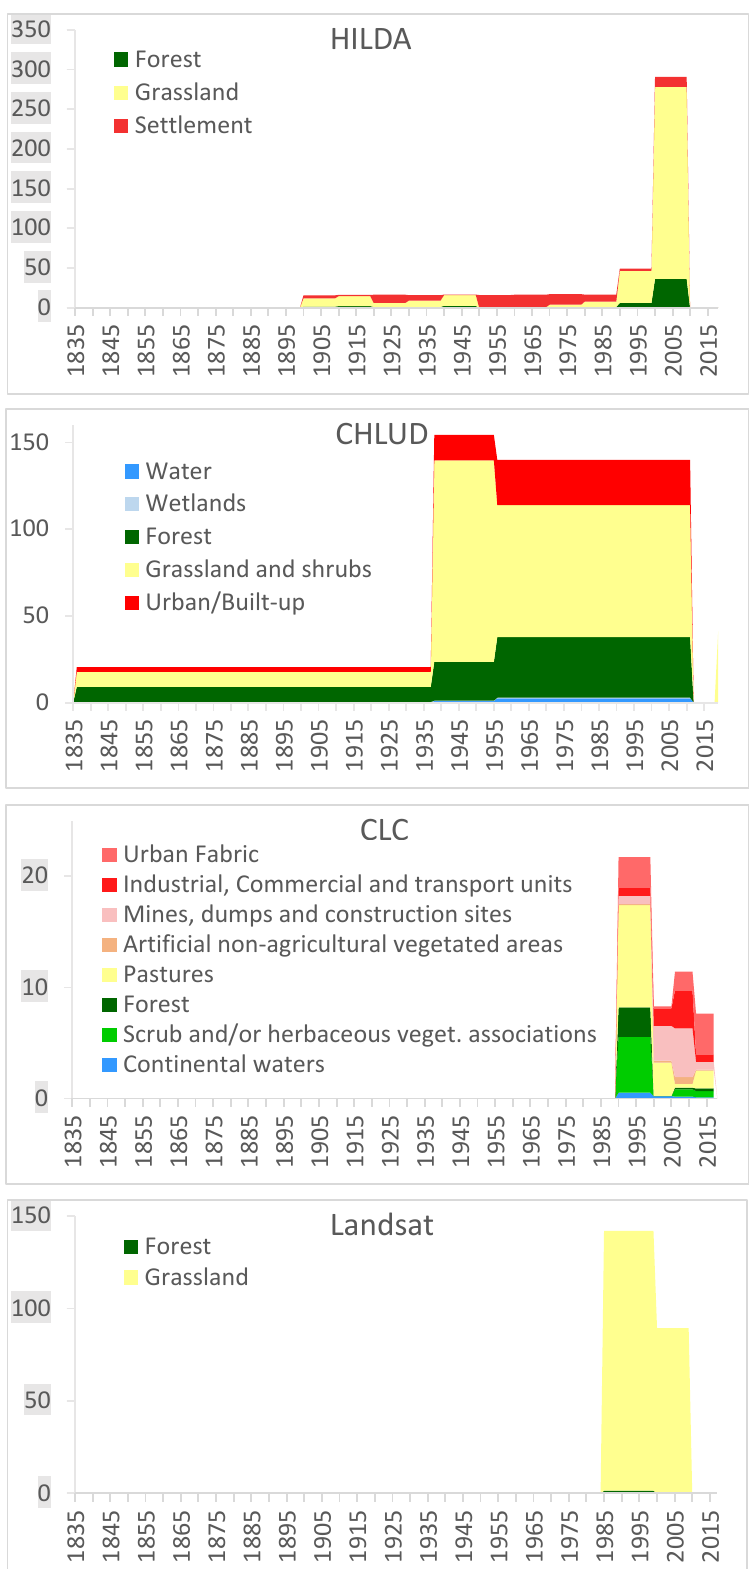
Figure 4. Changes in cropland area analysed from the land use/land cover data sources. Bottom axis: year, left axis: magnitude of cropland change to other land cover/land use category (km 2 /year).